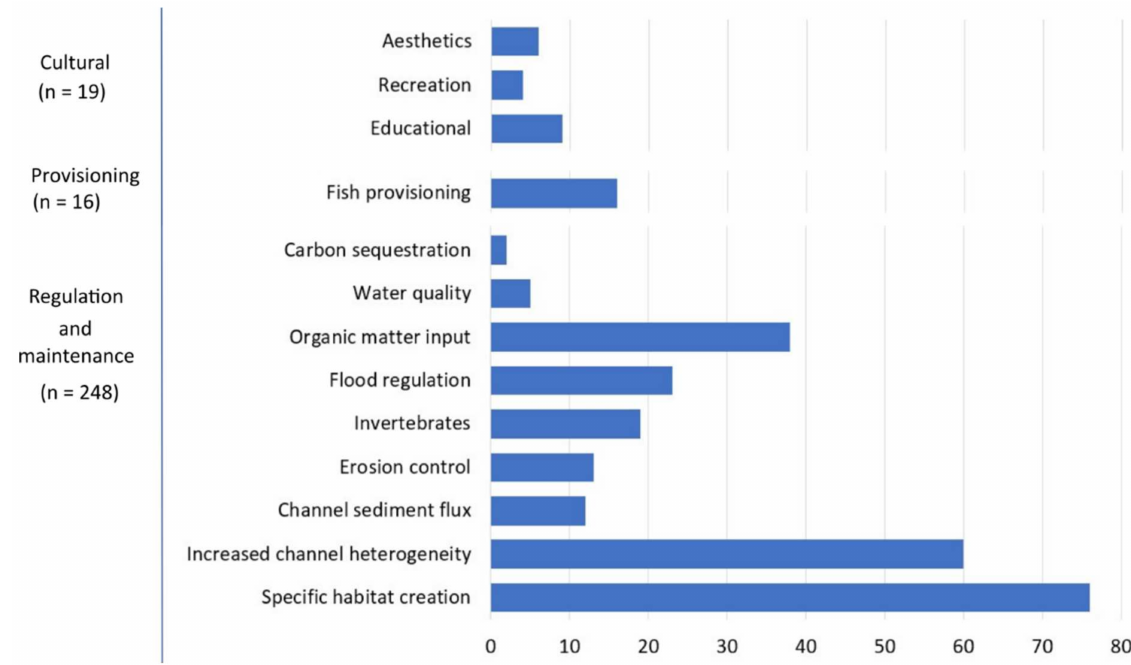
Figure 6. Distribution of ES in different sections ( n corresponds to the sum of the detected ES classes in the examined